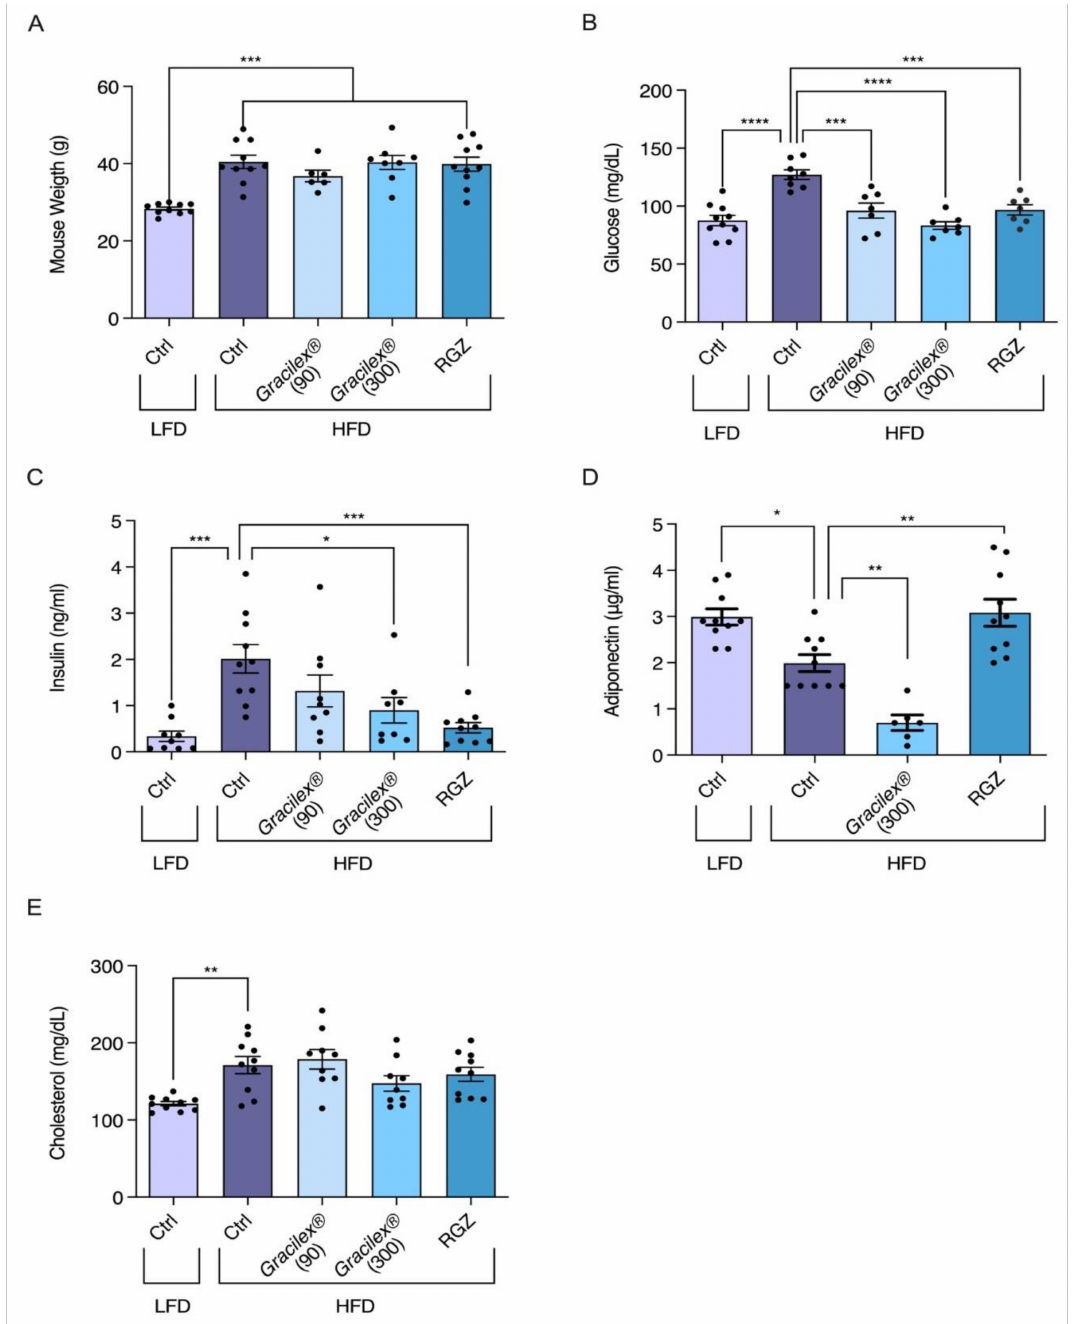
Figure 4. Gracilex ® improves altered glucose and insulin parameters in the plasma of male C57BL/6J mice given a HFD. After 6 weeks of LFD and HFD treatment, as indicated in Figure 3, LFD mice continued with the same diet and additional daily treatment with approximately 50 µ L of corn oil (vehicle for drugs) for 1 month (30 days). HFD-treated mice were divided into 4 groups and continued with the same diet, but 4 daily treatments were given: corn oil (vehicle), 90 and 300 mg/kg of Gracilex ® , and rosiglitazone (RGZ, 5 mg/kg). During the whole period, weights were recorded twice a week. The ( A ) comparison of weights at the beginning and end of treatment for each group. Values are expressed as mean ± SEM, n = 10, *** p < 0.001 (one-way ANOVA and Tukey’s post hoc test). ( B – E ) After treatment, mice were fasted for 15 h before taking blood samples; plasma glucose (mg/dL), plasma insulin (ng/mL), plasma adiponectin ( µ g/mL), and plasma cholesterol (mg/dL) values are shown. Values are expressed as mean ± SEM, n = 10. Significant differences are highlighted between LFD and HFD groups (left panels: ** p < 0.01, *** p < 0.001, unpaired t -test). Significant differences found in post-treatment experiments in HFD group were related to their HFD control. * p ≤ 0.05, ** p < 0.01, and *** p < 0.001 (one-way ANOVA and Tukey’s post hoc